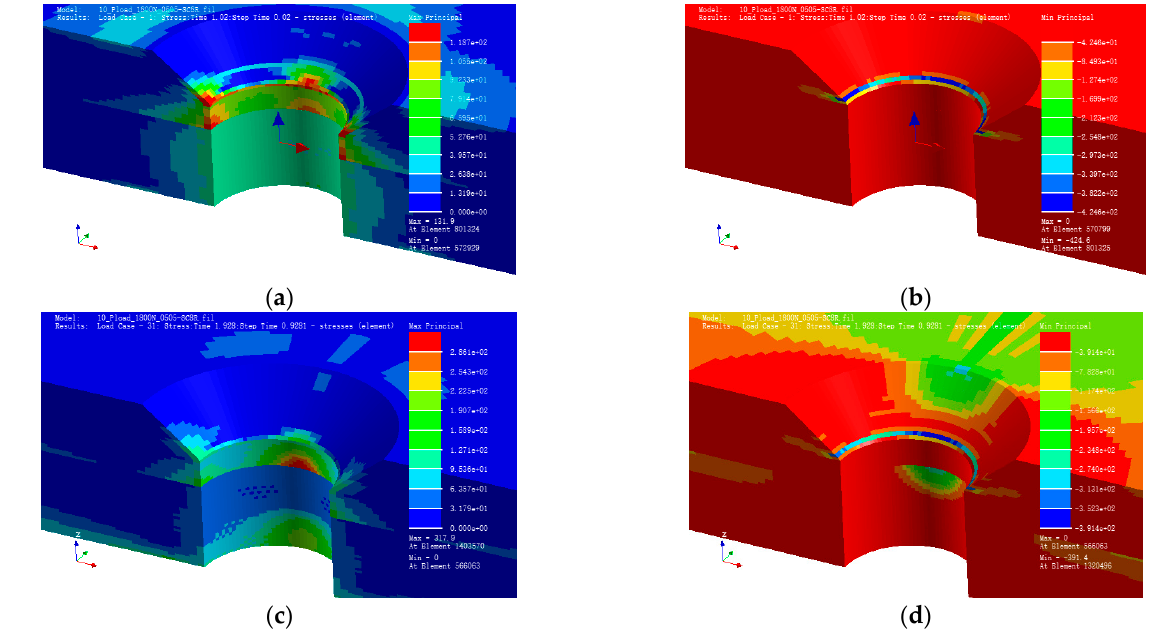
Figure 7. Max./Min. principal stress. ( a ) Max. principal stress. ( b ) Min. principal stress. ( c ) Max. principal stress. ( d ) Min. principal stress.